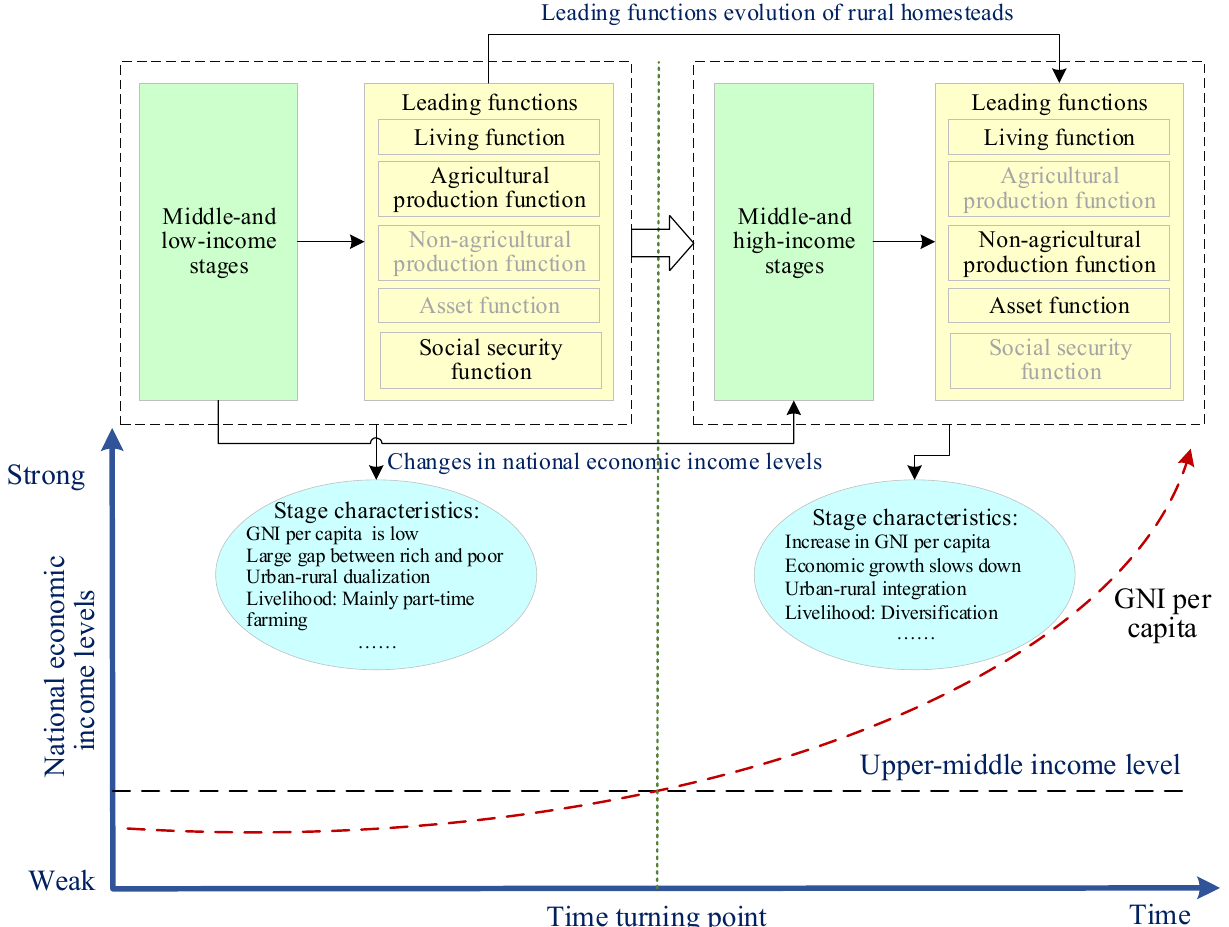
Figure 2. The analytical framework of rural-homestead functions evolution under the background of national economic-income-level change.